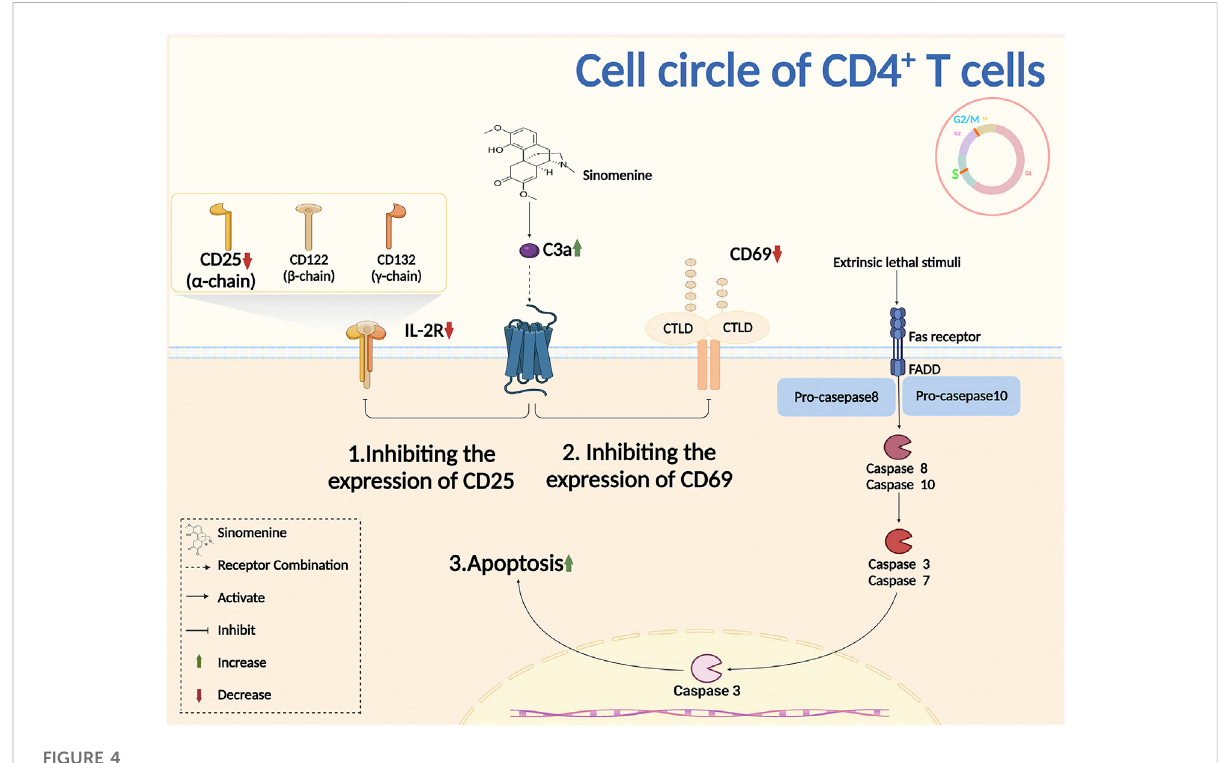
FIGURE 4 Sinomenine inhibits the proliferation of CD4+T